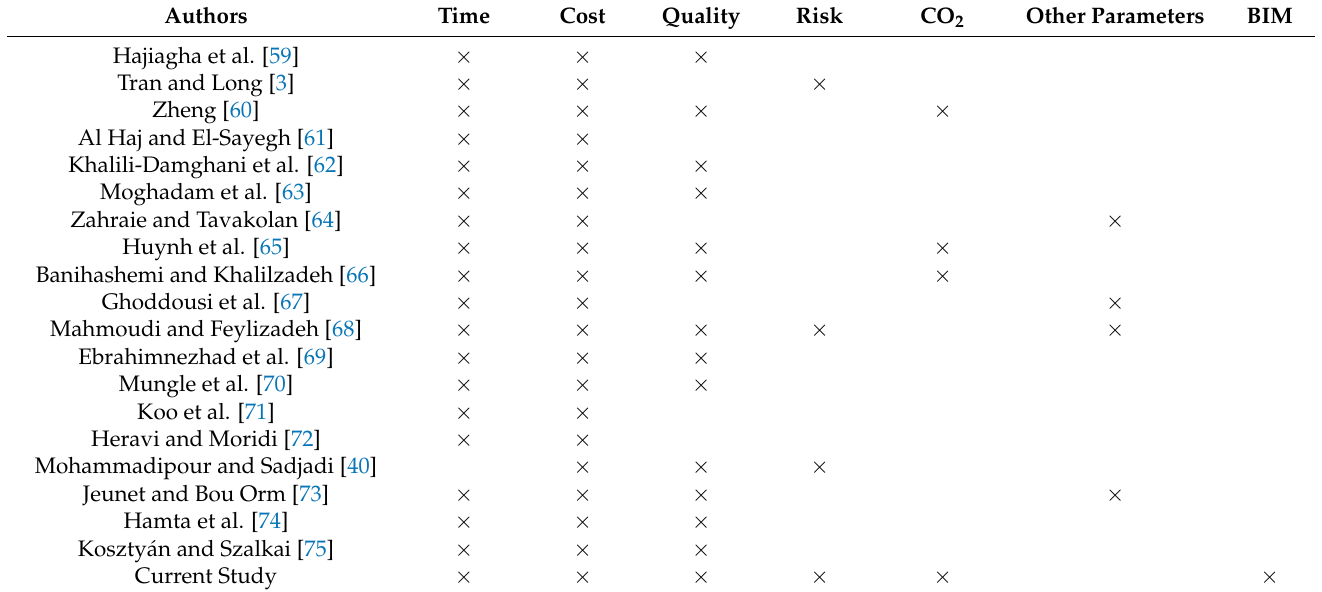
Table 1. Summary of previous related research